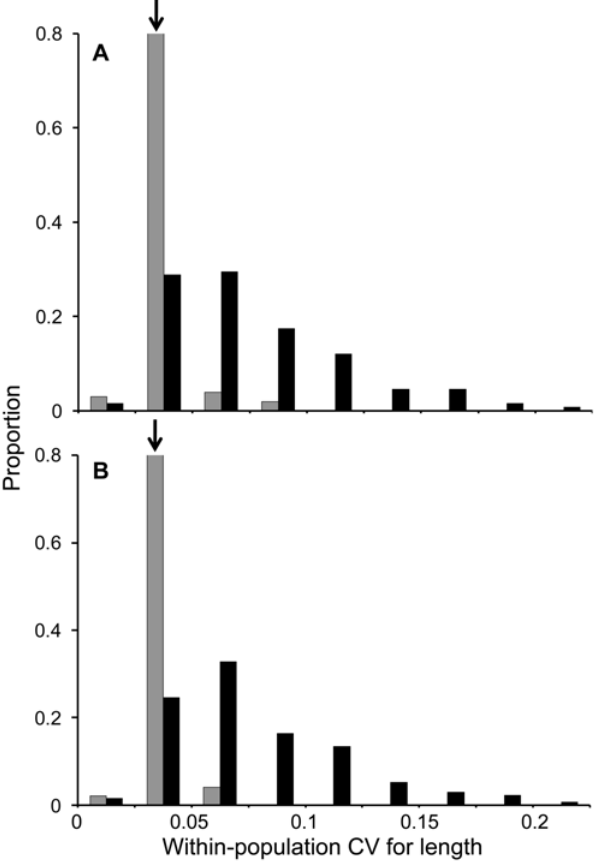
Figure 2. Distributions of coefficients of variation (CV) for within-population body length or height. Shown are species means for animals (black) and population means for humans (grey) for males (A) and females (B). Arrows indicate the locations of CVs for mean human height.